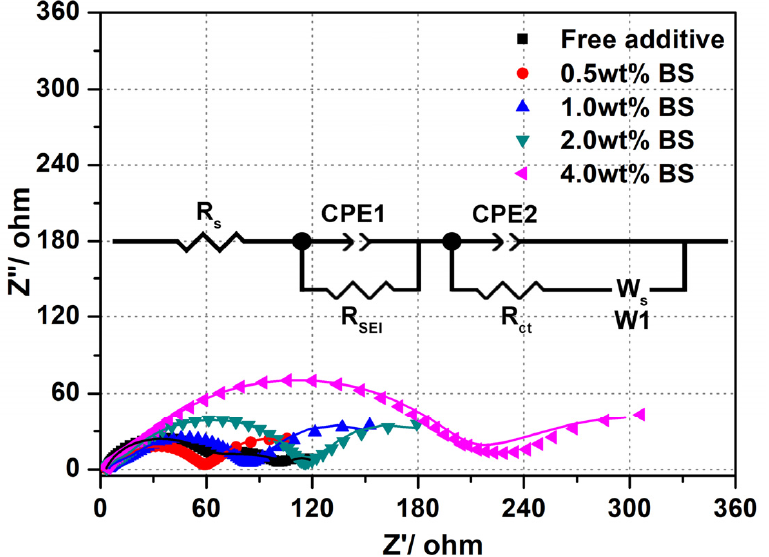
Figure 1. Cycling performances of LTO electrodes with the electrolytes containing different BS concentrations at the 0.2 C-rate.